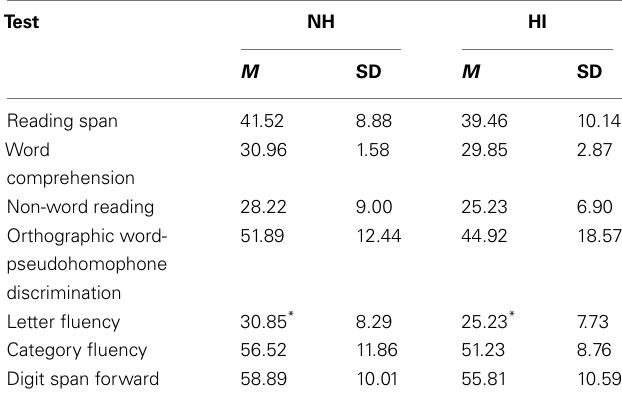
Table 3 | Means and standard deviations for the normal hearing (NH) and hearing-impaired (HI) groups on the cognitive tests.